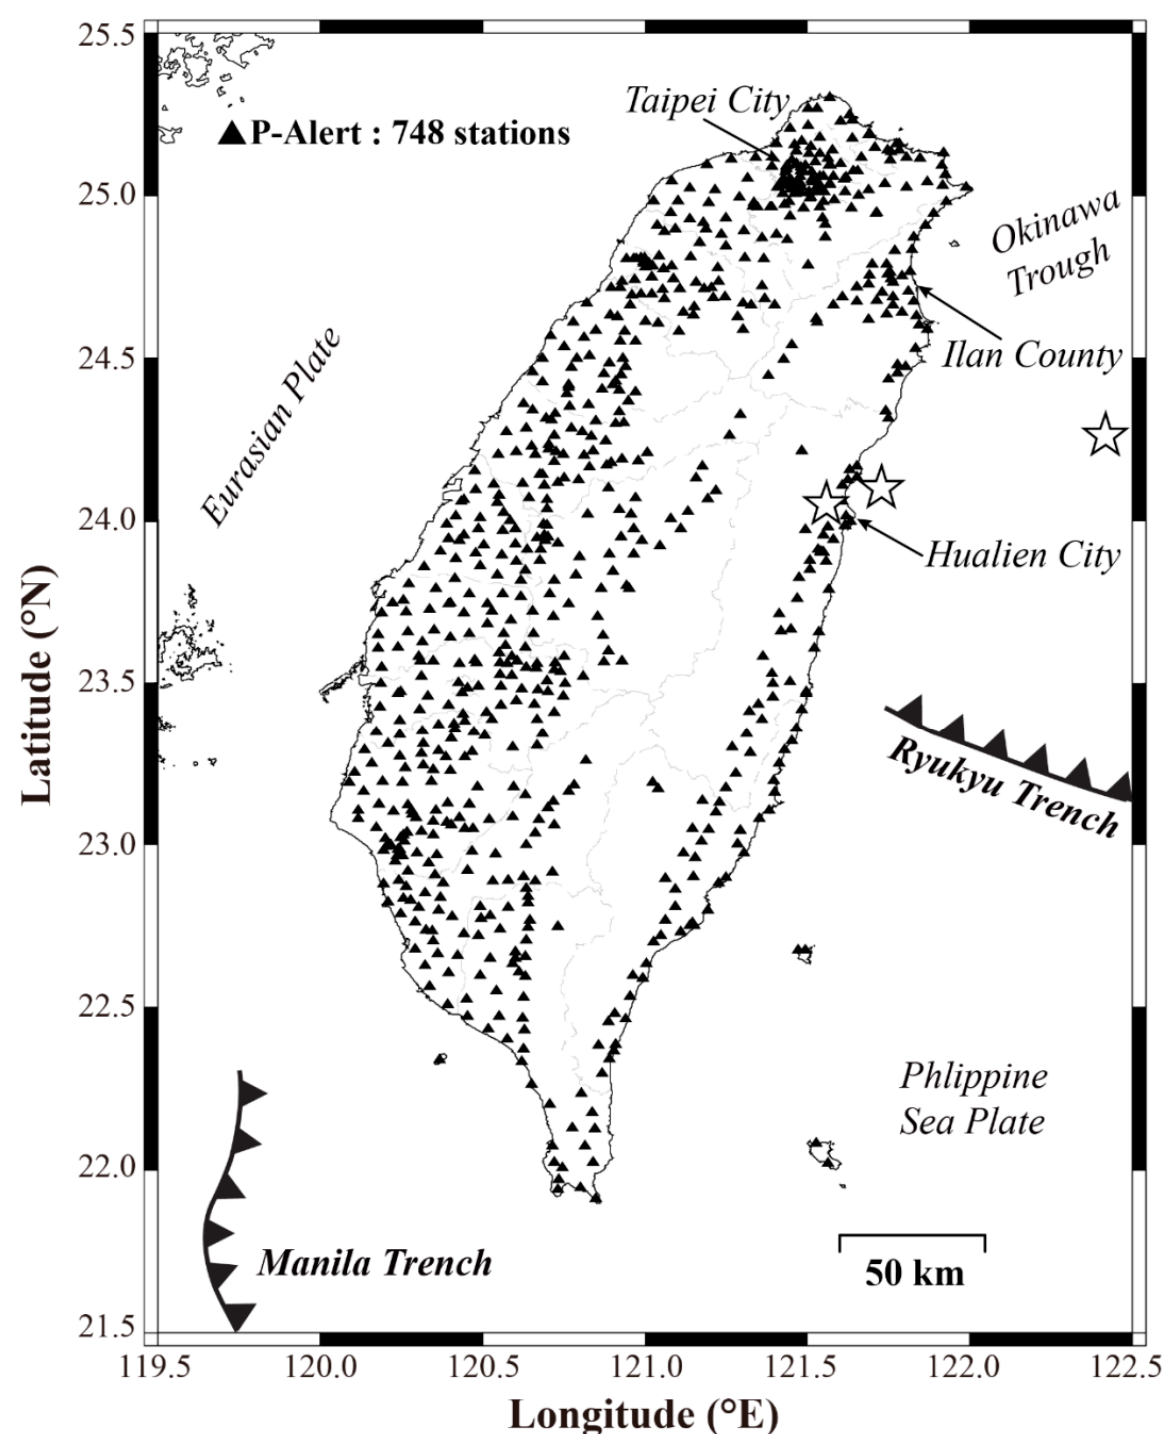
Figure 1. The seismotectonic settings of Taiwan along with the distribution of P-Alert instruments in different parts. The stars represent the epicenters of the earthquakes mentioned in sections 4 & 6.